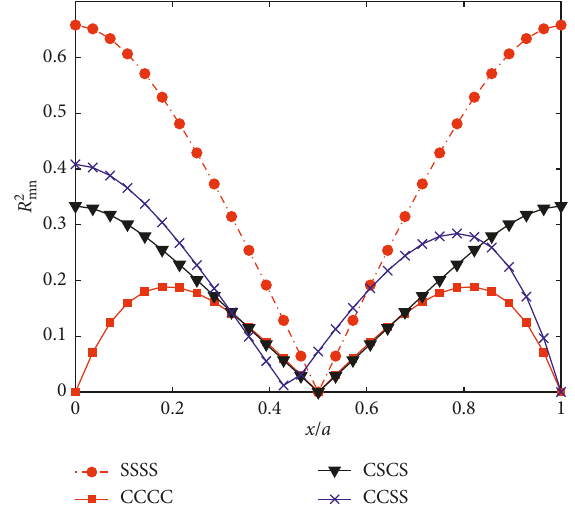
Figure 8: The slip between the top and bottom layers at the contact place varying along the x -direction, with k h h � n / m